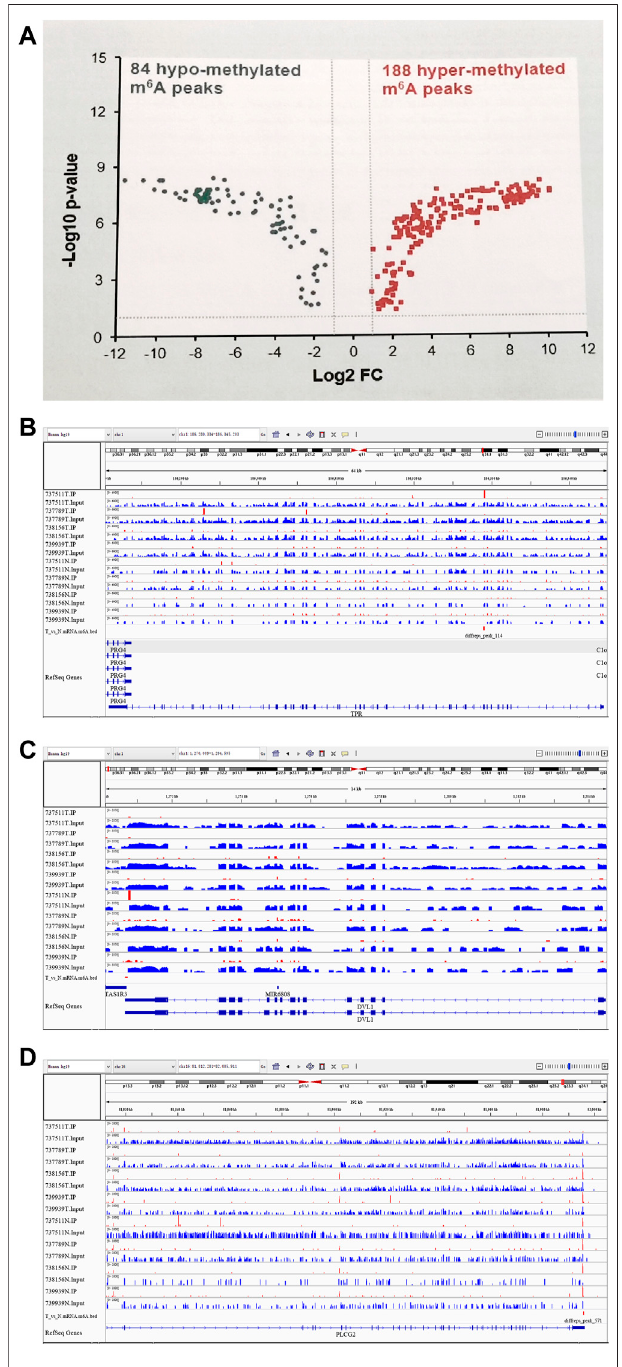
FIGURE 2 | Differentially methylated N 6 -methyladenosine peaks in the tumer and control groups. (A) 188 m 6 A hypermethylation sites and 84 m 6 A hypomethylation sites. (B) A representative up-methylated gene in the tumor group relative to the control group. (C,D) two representative down- methylated genes in the tumor group relative to the control